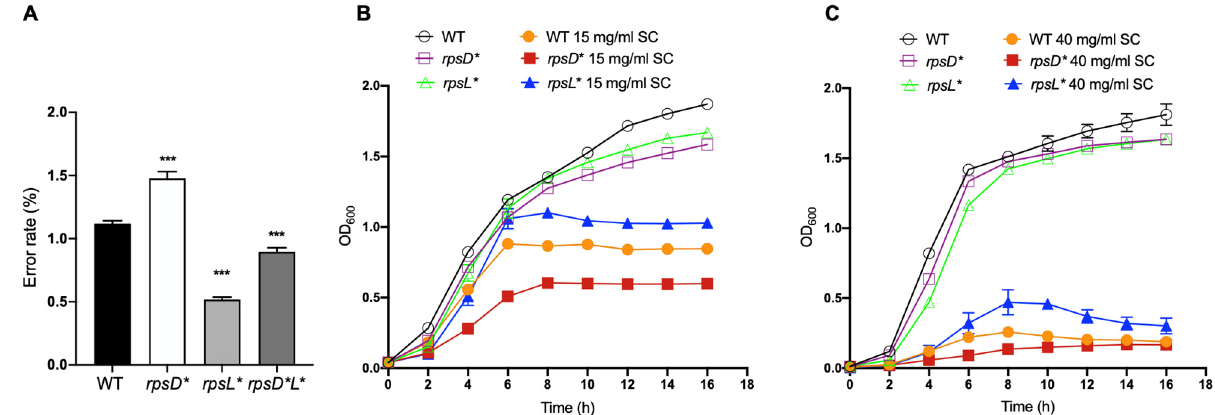
Figure 1. Increased translational fidelity improves growth under bile salt stress. ( A ) UGA readthrough translational errors were measured using dual-fluorescence reporters. Cells harboring the reporters were grown in Luria-Bertani broth (LB) at 37 ◦ C for 16 h. Fluorescence signals were quantified using a plate reader. ( B , C ) Growth curve of Salmonella strains in the presence of 15 mg/mL or 40 mg/mL sodium cholate. Overnight cultures were diluted 1:100 in fresh LB with or without sodium cholate and incubated at 37 ◦ C for 16 h with shaking. OD 600 was determined using a microplate reader. The results are the average of at least three biological repeats with error bars representing the standard deviations. The p -values are determined using the independent t -test. ***, p < 0.001.